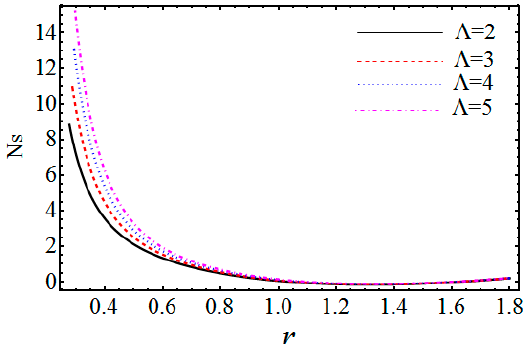
Figure 18. Curves of Ns with fixed Λ where θ = 0.3, ϕ = 0.8, δ = 0.01, ε = 0.01, V = 0.3, λ 1 = Figure 18. Curves of 𝑁𝑠 with fixed Λ where 𝜃 = 0.3, 𝜑 = 0.8,𝛿 = 0.01, 𝜀 = 0.01, 𝑉 = 0.3, 𝜆 (cid:2869) = 1, z = 0, t = 0.1, Ω = 0.3, Gc = 0.01, Nt = 0.5, Br = 1, Gr = 3, Γ = 0.4, Nb = 0.9, Q = 1.. 1, 𝑧 = 0,𝑡 = 0.1,Ω = 0.3, 𝐺𝑐 = 0.01,𝑁𝑡 = 0.5,𝐵𝑟 = 1,𝐺𝑟 = 3, Γ = 0.4,𝑁𝑏 = 0.9,𝑄 = 1. Figure 18. Curves of 𝑁𝑠 with fixed Λ where 𝜃 = 0.3, 𝜑 = 0.8,𝛿 = 0.01, 𝜀 = 0.01, 𝑉 = 0.3, 𝜆 (cid:2869) = 1, 𝑧 = 0,𝑡 = 0.1,Ω = 0.3, 𝐺𝑐 = 0.01,𝑁𝑡 = 0.5,𝐵𝑟 = 1,𝐺𝑟 = 3, Γ = 0.4,𝑁𝑏 = 0.9,𝑄 = 1.